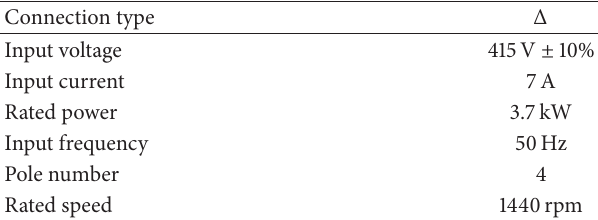
Table 1: Technical specifications of three-phase induction motor.